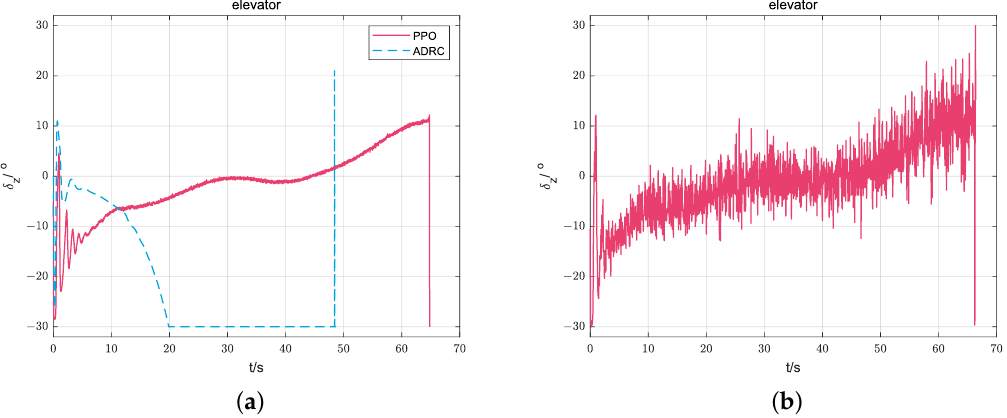
Figure 8. Elevator deflection when no fault occurs. ( a ) elevator deflection, ( b ) elevator deflection without R δ . z